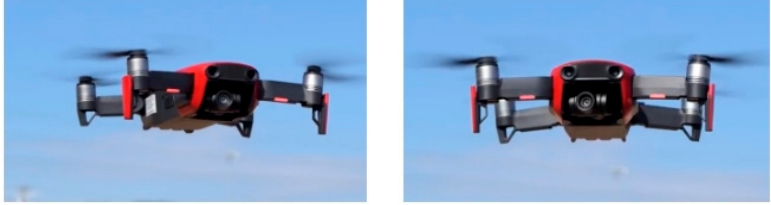
Figure 7. Testing images used to evaluate the suitability of feature detectors.